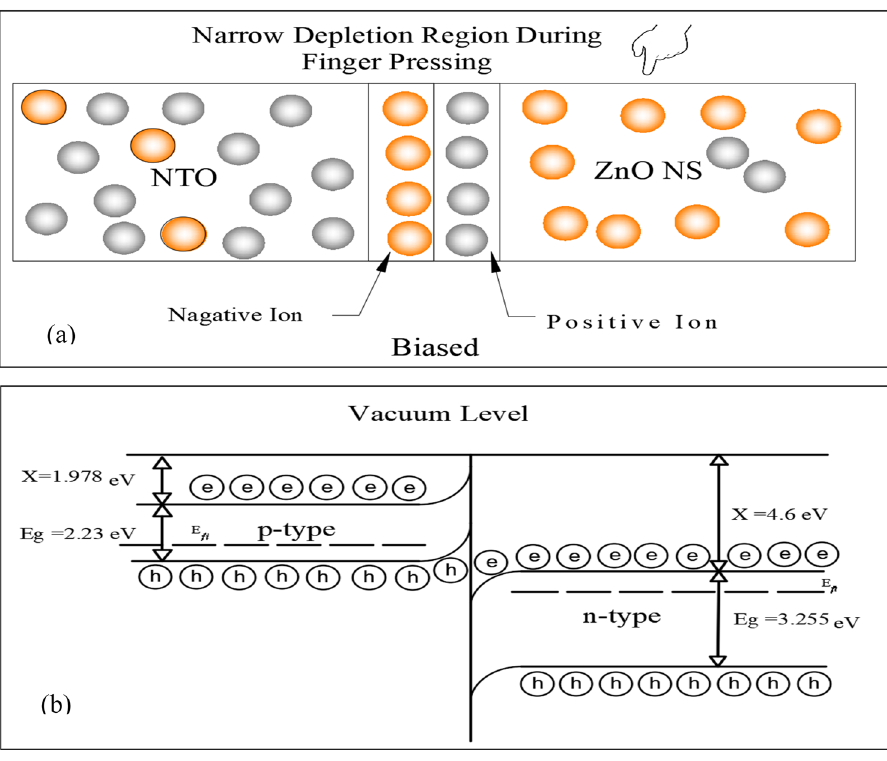
Figure 10: Schematic drawing fi nger press e ff ect: ( a ) recti fi cation and transformation of the carriers and ( b ) the con fi guration of the broken band gap under pressing.